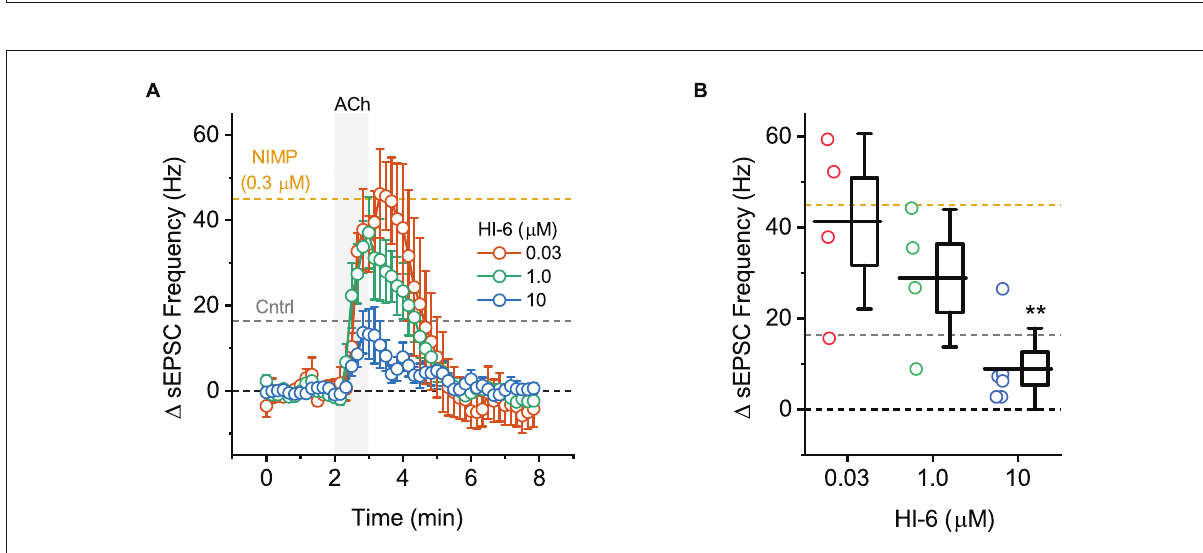
FIGURE4 ACh-induced increases in sEPSC frequency in BLA pyramidal neurons can be used to quantify the effectiveness of AChE reactivators in slices preincubated with NIMP. (A) ACh-induced change in sEPSC frequency over time as produced by acute bath application of ACh in BLA pyramidal neurons preincubated in 0.3 µ M NIMP, and then treated with various concentrations of AChE reactivator HI-6 as indicated in the legend. See “Results”/”Materials and methods” Section for further details. (B) Summary data illustrating the ACh-induced change in sEPSC frequency, observed from 3 to 4 min as plotted in panel (A) , for each cell tested. For each group, box height illustrates the SEM, whiskers illustrate the SD, and horizontal lines highlight the group means. In both panels, the dashed gray and orange lines highlight the mean ACh-induced change in sEPSC frequency as observed at 3–4 min in BLA pyramidal neurons from control and NIMP datasets as illustrated in Figure 2B . Dashed black line highlights 0 pA. **Indicates p ≤ 0.05 compared to responses observed in slices treated identically with NIMP but not exposed to HI-6. See text of results and Table 1 for further